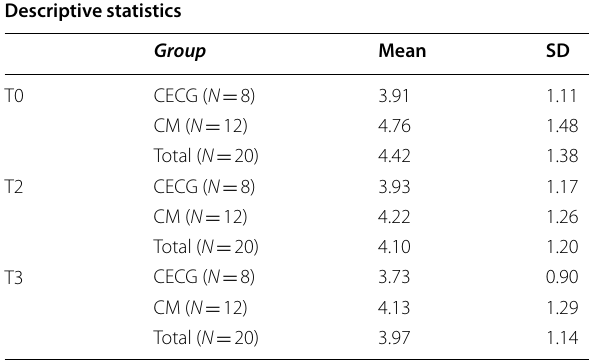
Table 2 Mean values and standard deviation of the measured widths of the keratinzed gingiva at the T0 (before tooth removal), T2 (after second stage surgery) and T3 (after prosthetic restoration)